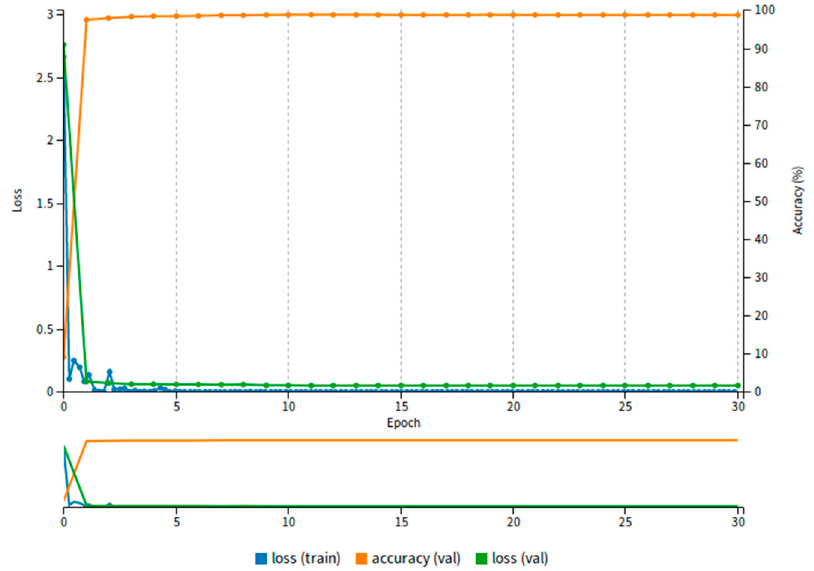
Figure 4. The changes in the value of L-Softmax loss as the increasing of training epoch on the KITTI dataset.